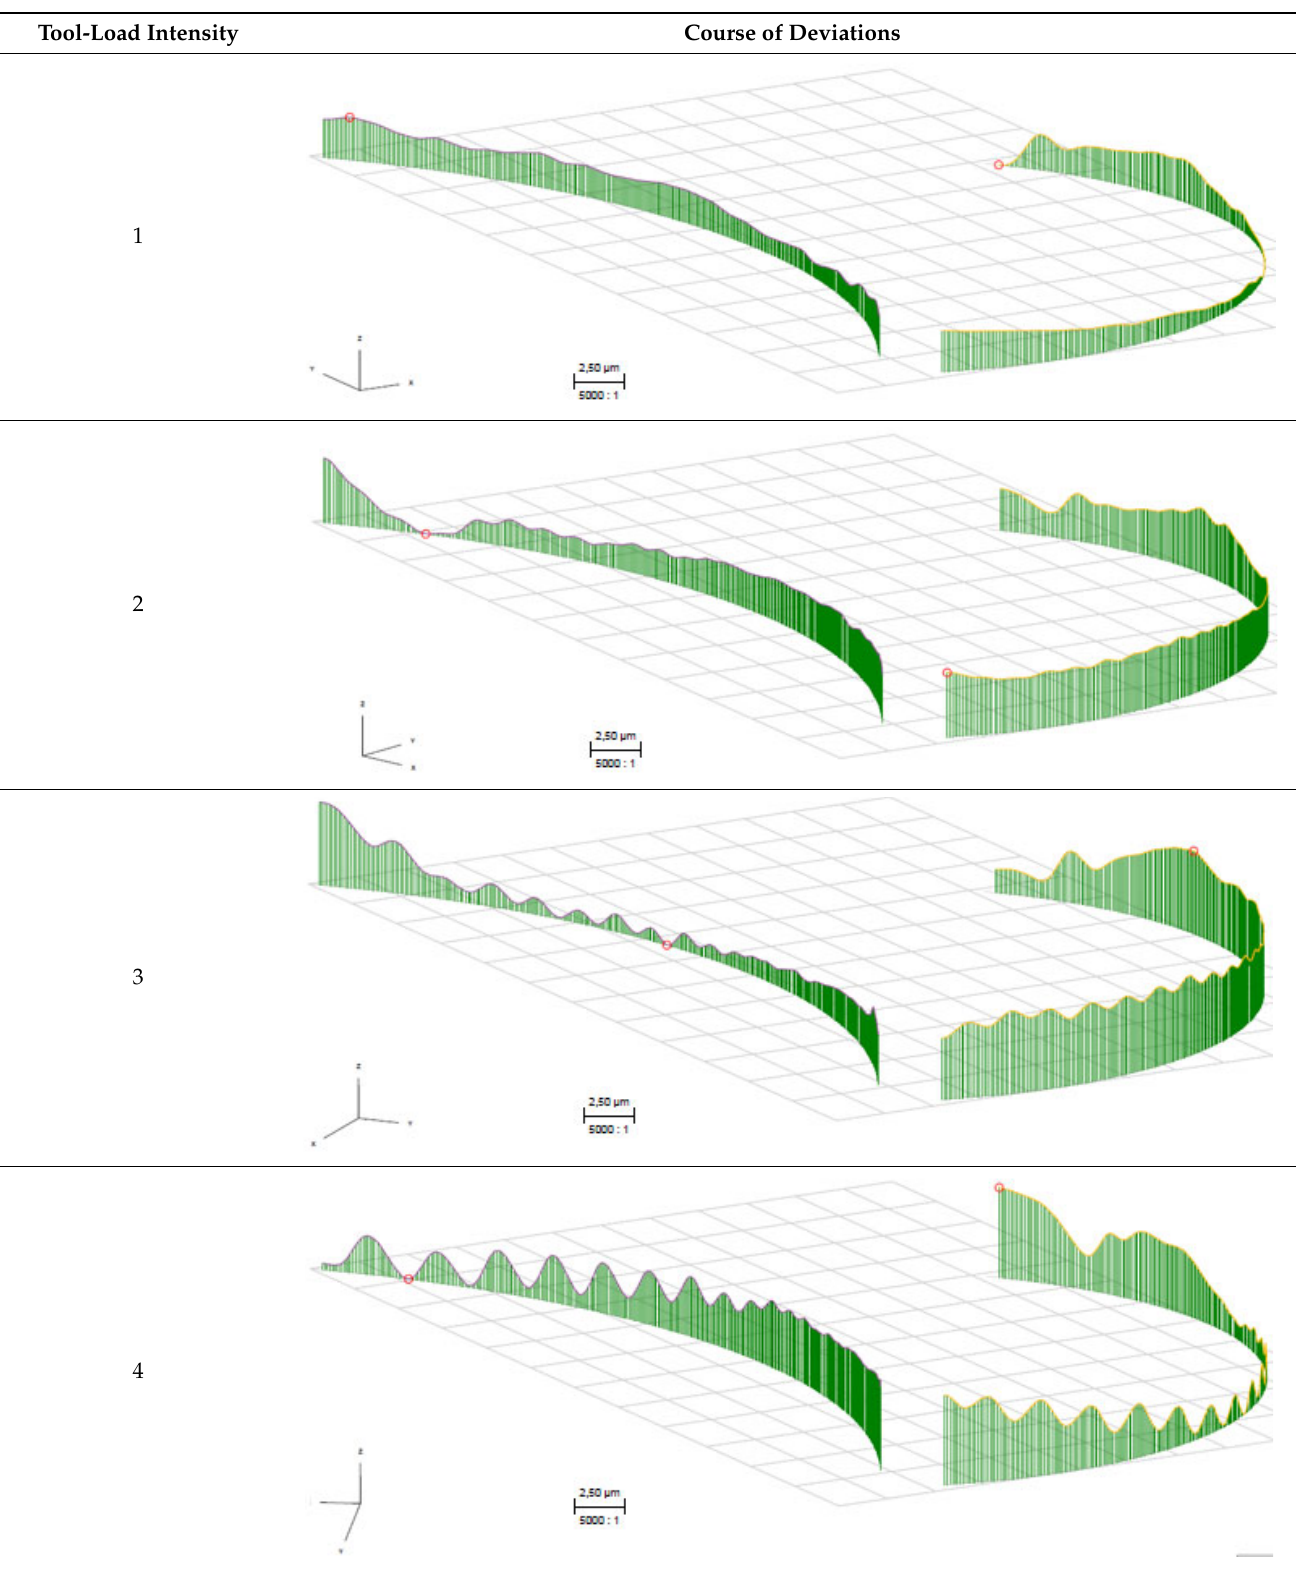
Table 6. Deviations at the bottom of the pockets made with the optimization software.